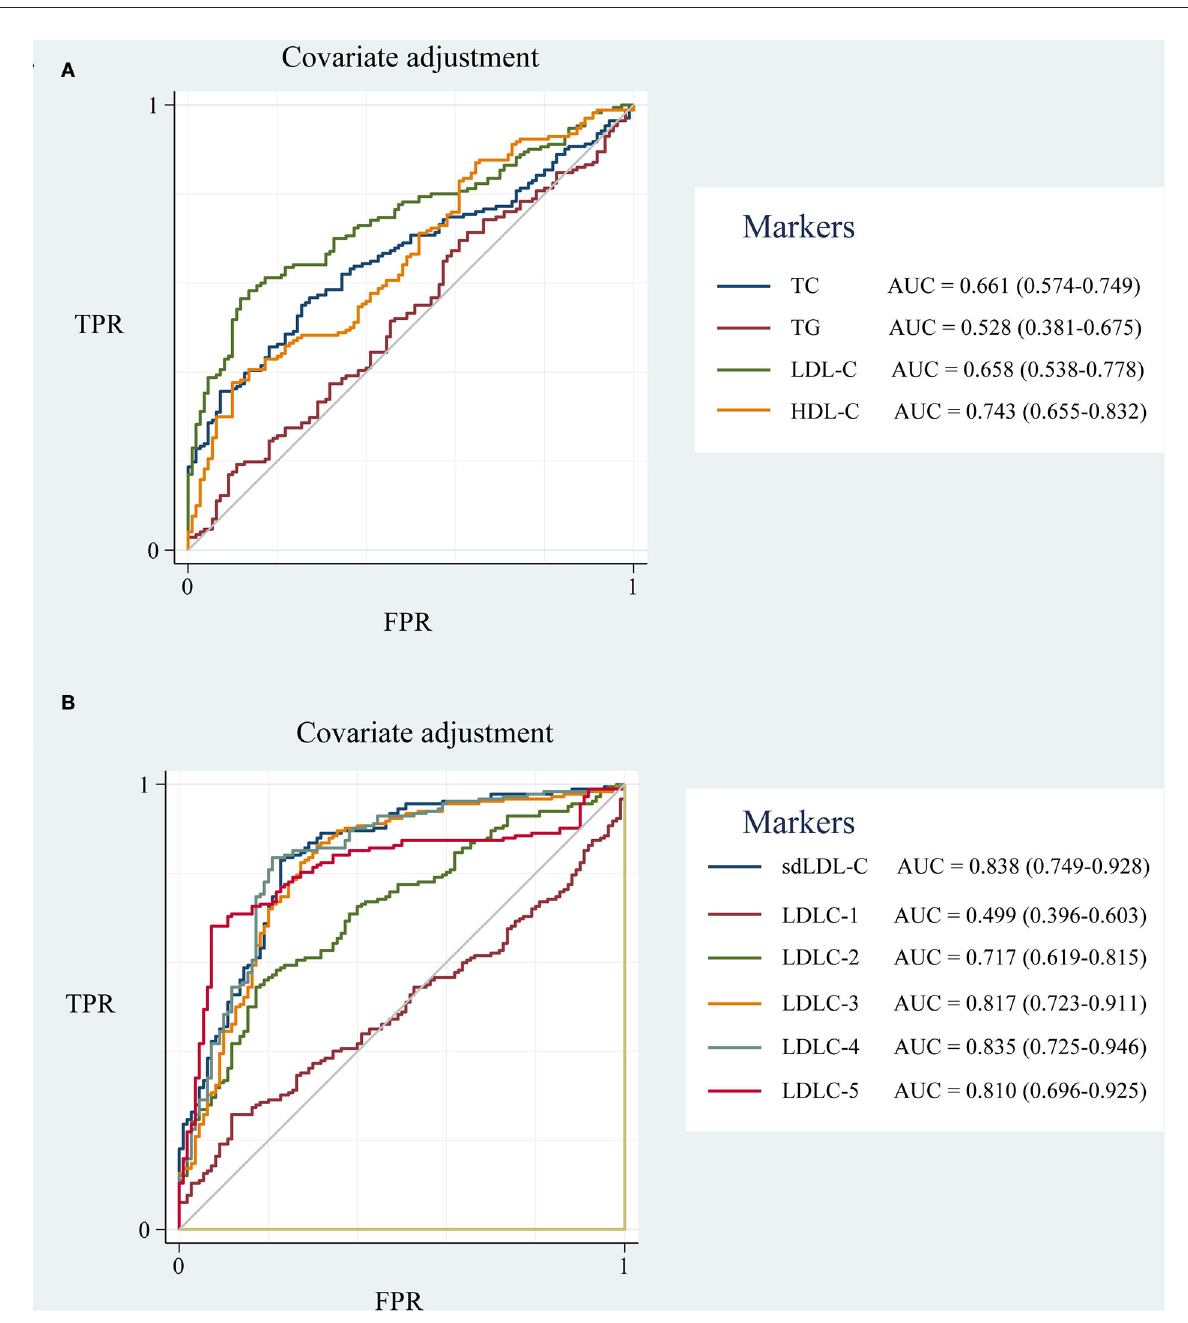
gender ( P = 0.045) and smoking history ( P = 0.038) between the SLCO1B1 c.521TT and c.521TC/TT groups. After adjustment of covariances, the results indicated